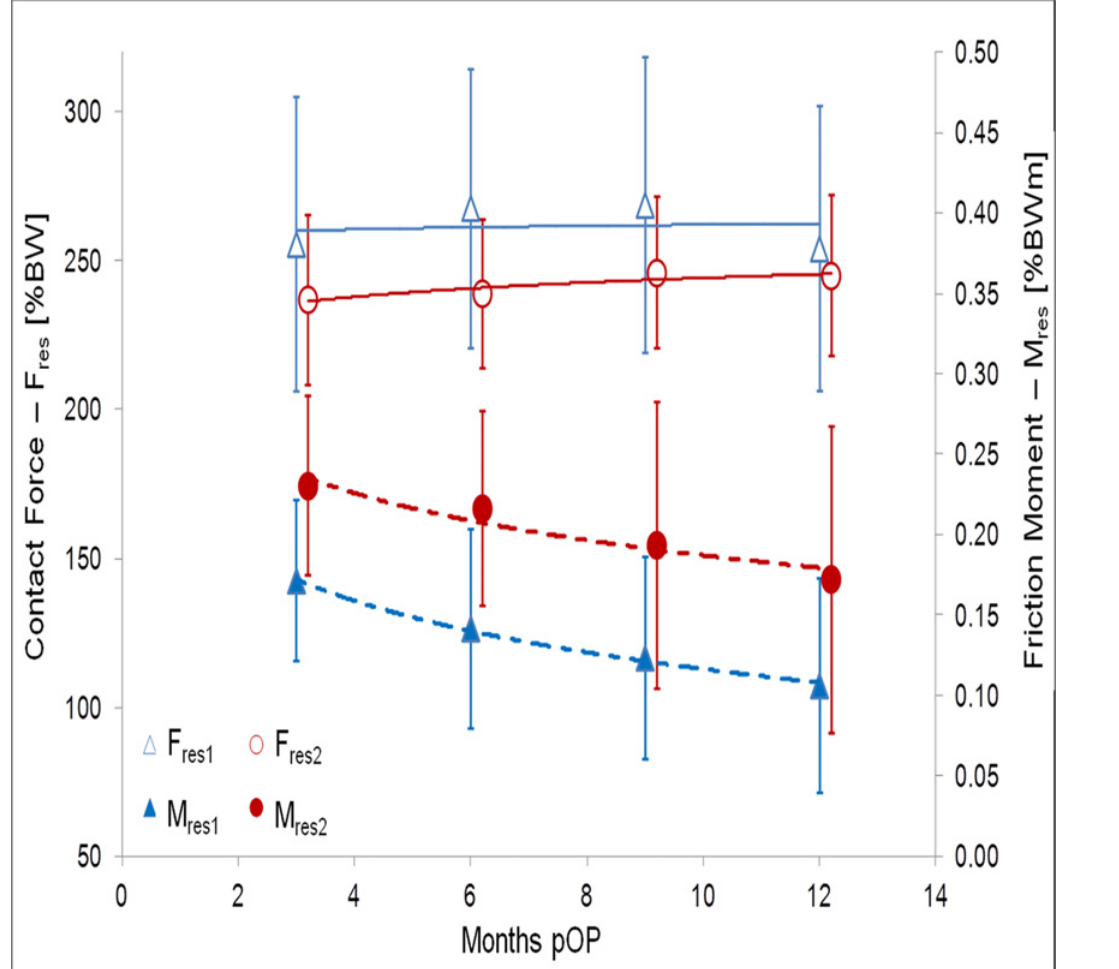
Fig 3. Postoperative changes of contact forces and friction moments. Average and standard